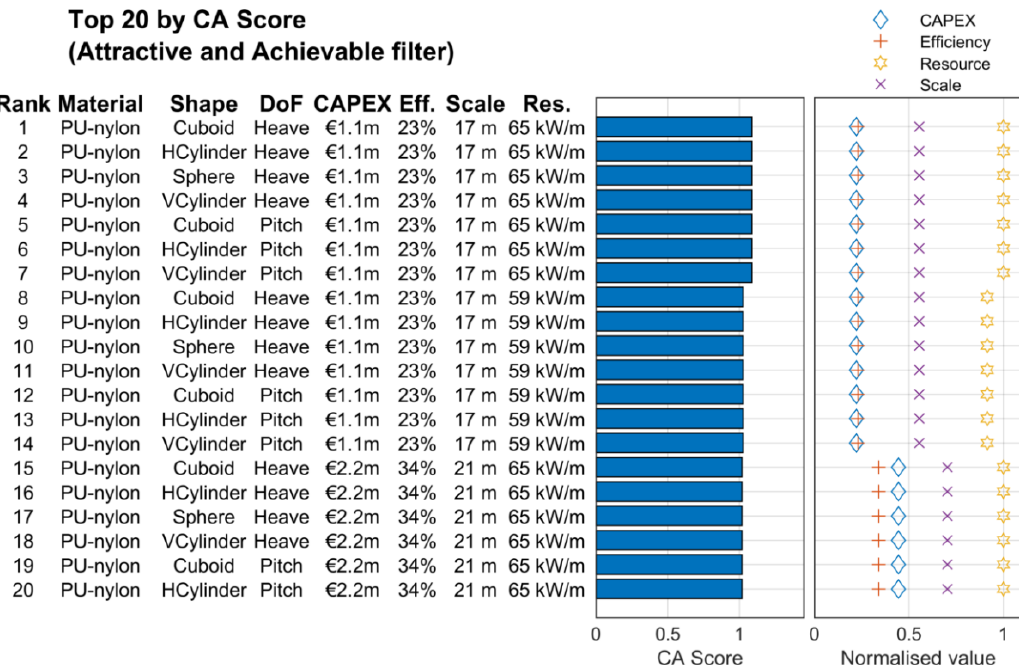
Figure 9. Graphical representation of the results with zoomed in scale (10–30 m) showing the what-if range parameters as columns of the top 20 most attractive and achievable scenarios ranked by CA score. Normalised values of the what-if range parameters can be seen on the right. Zooming out on the CAPEX showed that lower values of CAPEX are achievable, whilst zooming in on the scale showed that a smaller scale is the most attractive, relative to the results in Table 10.